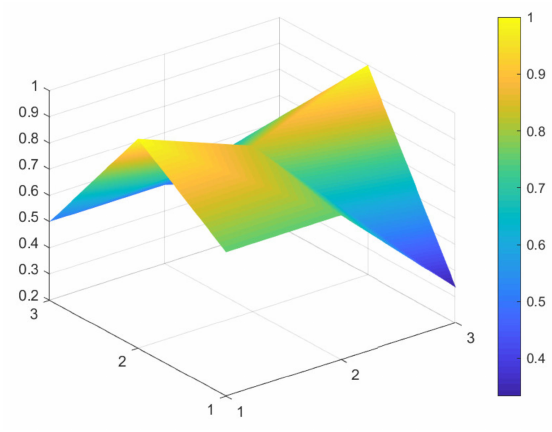
Figure 3. PMC-Surface chart of P1